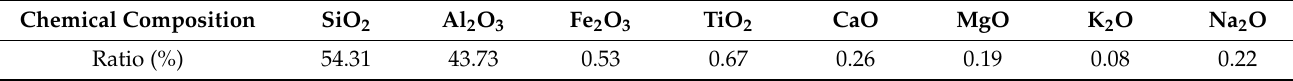
Table 2. Chemical compositions of raw materials